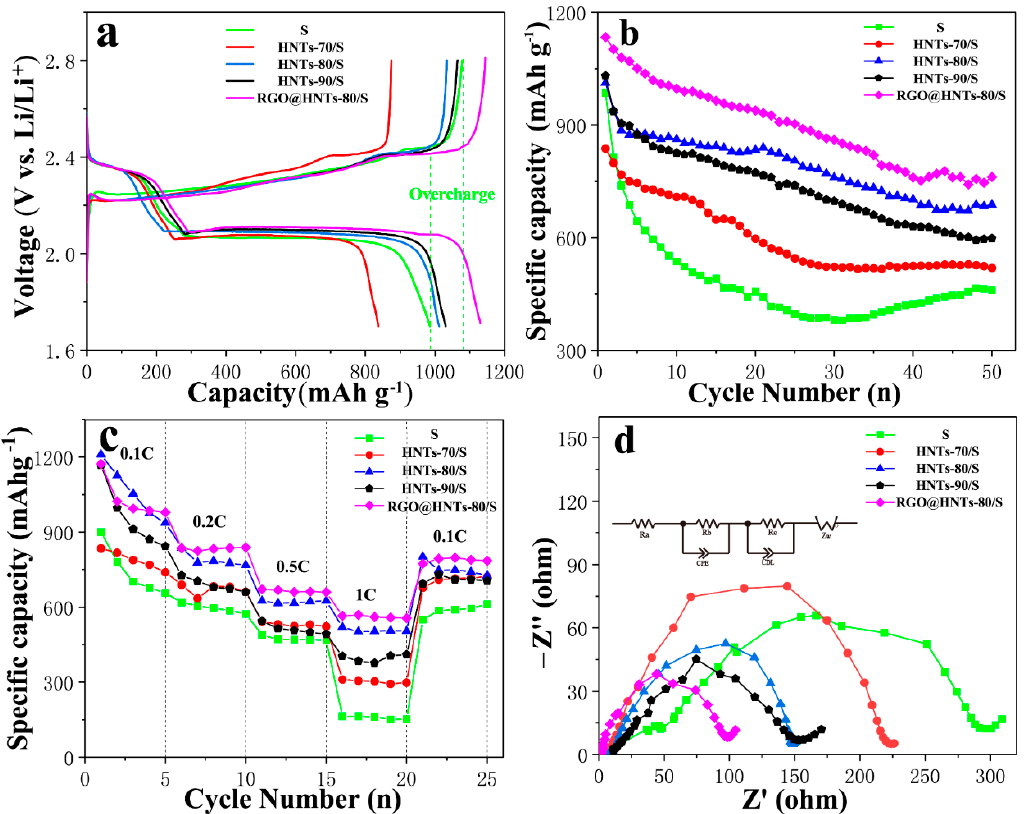
Figure 5. ( a ) Initial galvanostatic discharge/charge voltage profiles; ( b ) Cycling performance comparisons between normal S,HNTs/S and RGO@HNTs/S cathode at current rate of 0.1 C (1 C = 1675 mAh/g); ( c ) Rate capability of normal S, HNTs/S and RGO@HNTs/S cathode with different current densities; ( d ) Impedance spectroscopy analysis of normal S, HNTs/S and RGO@HNTs/S cathode.